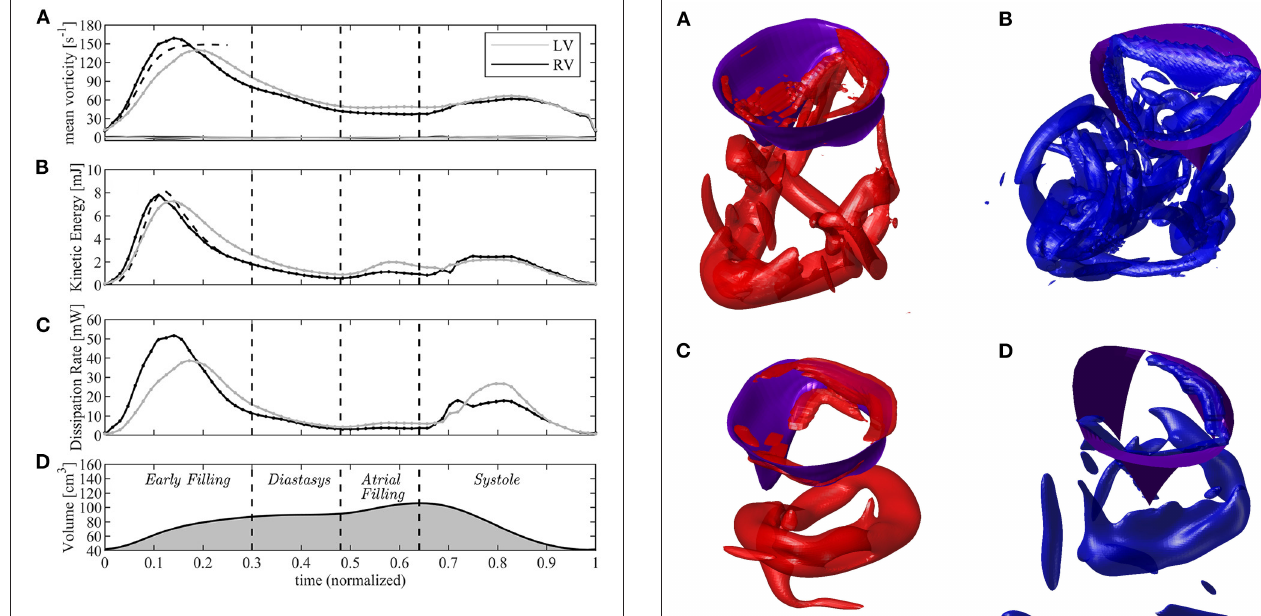
FIGURE 5 | Graphical representation of the vorticity and energetic analysis in left ventricle (LV) (gray lines) and right ventricle (RV) (black); (A) mean vorticity, (B) kinetic energy, (C) dissipation rate, (D) volume curve (for timing reference). The dashed lines in A and B are the asymptotic short time estimates.